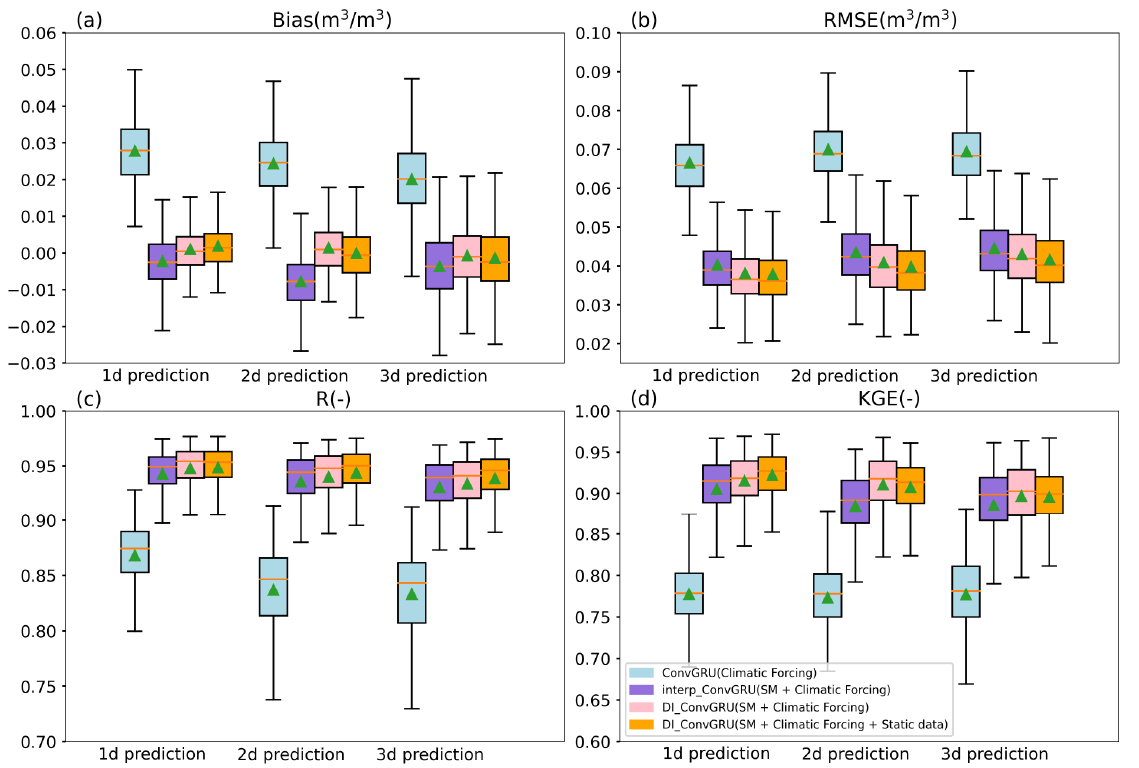
Figure 8. Box plots of the Bias, RMSE, R and KGE of models trained with different datasets during the tested period. Those four models were trained using ( a ) ConvGRU with Climatic Forcing data (blue; including the lagged precipitation, temperature, radiation, humidity, and wind speed, where the lagged time is 1 day). ( b ) interp_ConvGRU with SM (lagged SMAP L3 SM gap filled by linearly interpolation) and Climatic Forcing data (purple); ( c ) DI_ConvGRU with SM (lagged SMAP L3 SM) and Climatic Forcing data (pink); and ( d ) DI_ConvGRU with SM (lagged SMAP L3 SM), Climatic Forcing and Static data (blue; including sand, silt, clay content, bulk density, land cover type and